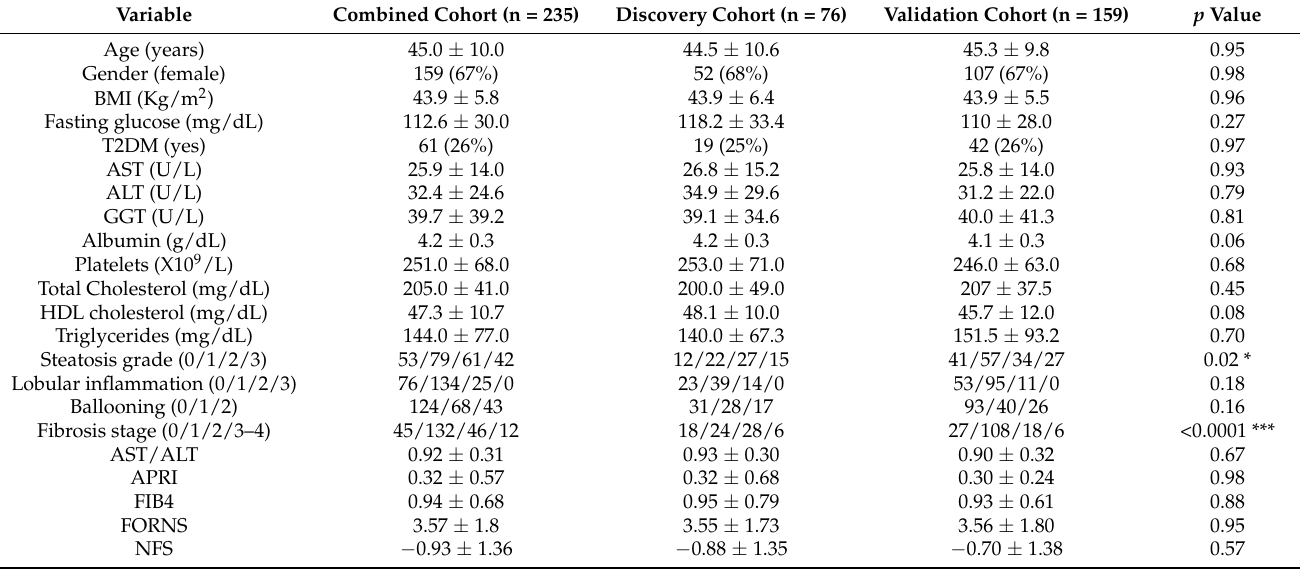
Table 2. Clinical characteristics of all morbidly obese